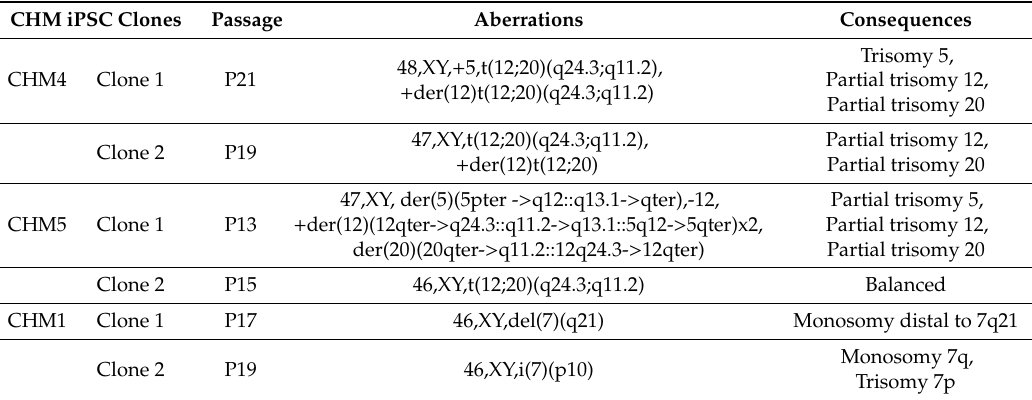
Table 1. Summary of the chromosomal aberrations carried by the CHM iPSC